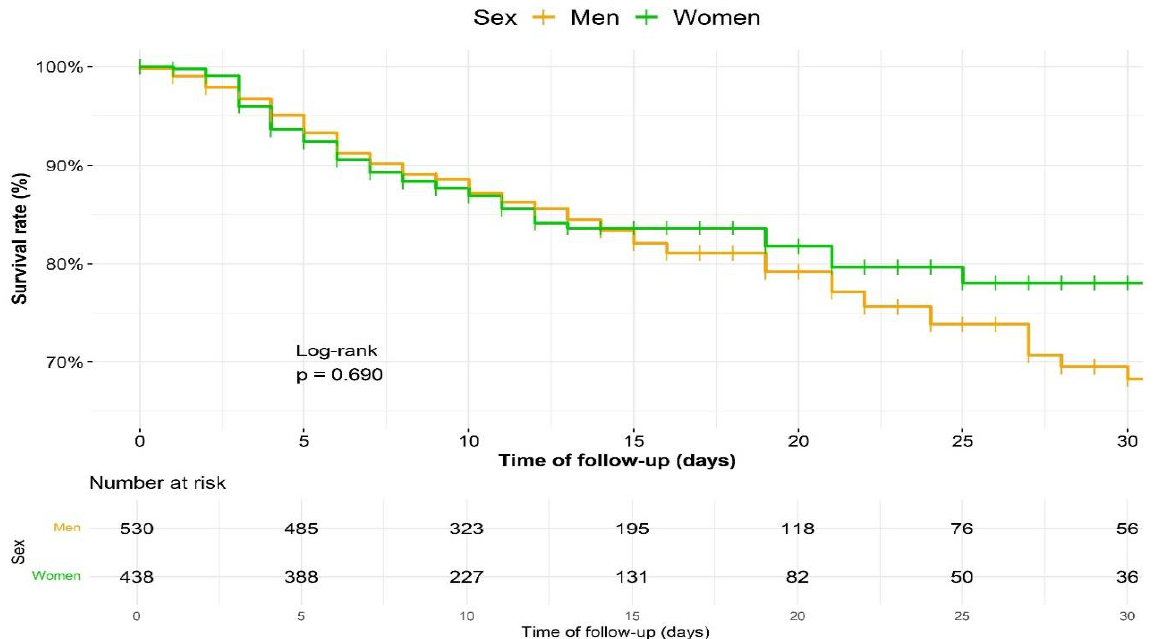
Figure 3. Survival analysis of men and women, until day 30 of hospitalisation. At day 7, the survival rate was 90.2% in men and 89.2% in women; at day 30, it was 68.3% in men and 78.08% in women. There were no significant differences between sexes (log-rank test p = 0.690). We also performed the survival analysis of men and women with COVID-19 stratified by CURB-65 score upon admission (Figure 4). Important differences were observed among patients with low risk (LR, score 0–1) and those with medium or high risk (MHR, score 2–5). Survival rate at day 30 in men was 80.1% in LR and 47.4%